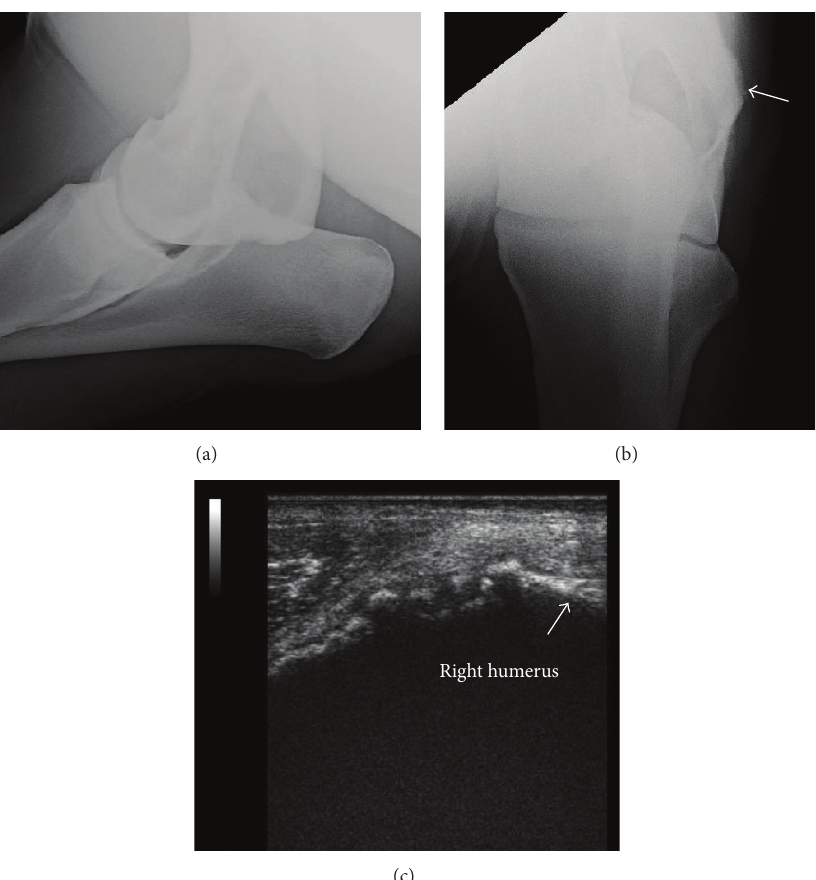
Figure 1: Radiographs of the right elbow at first presentation in (a) lateromedial and (b) craniocaudal views. A faint lucency is noted in the lateral aspect of the condyle of the right humerus. There is mild periosteal bone proliferation on the lateral aspect of the distal humerus metaphysis and condyle (marked by white arrow), which is best noted in the craniocaudal view. (c) Ultrasound image of the lateral aspect of the condyle of the right humerus. A marked irregularity of the bone surface just proximal of the origin of the lateral collateral ligament (marked by white arrow) of the right elbow joint is